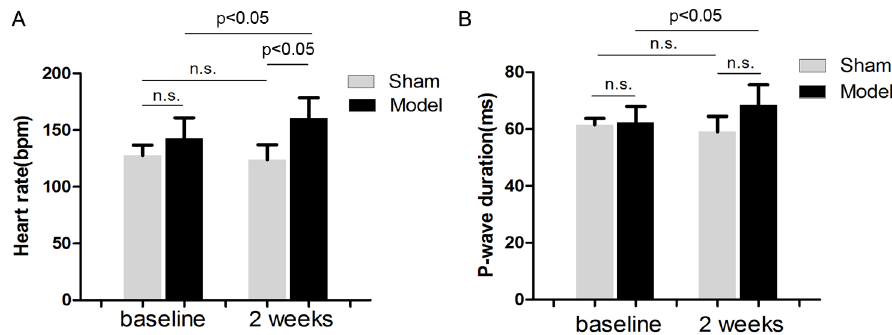
Figure 2. ECG analysis (n=5). Effects of embolization versus sham operation on heart rate (A) and P-wave duration (B).